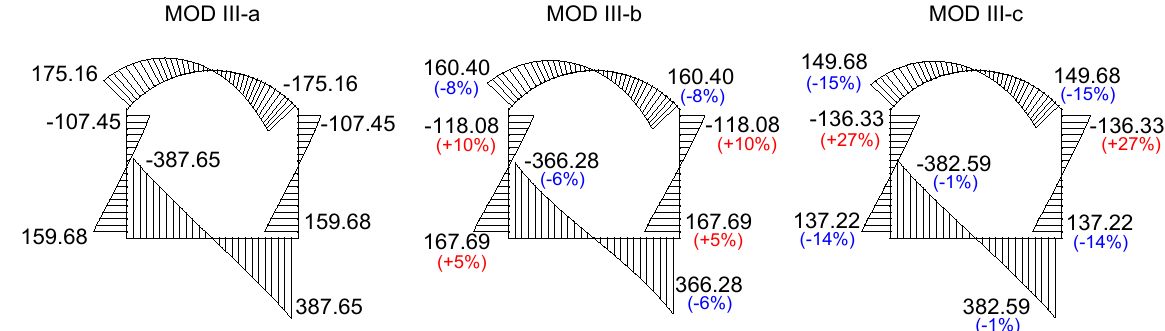
Figure 13. Shear force (kN) for different wall thicknesses in modified culvert (H =